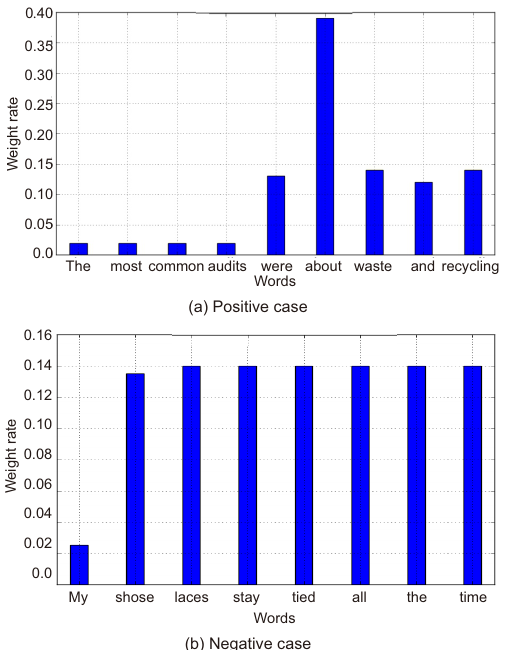
Fig. 6 Graphical representation of attention weights.